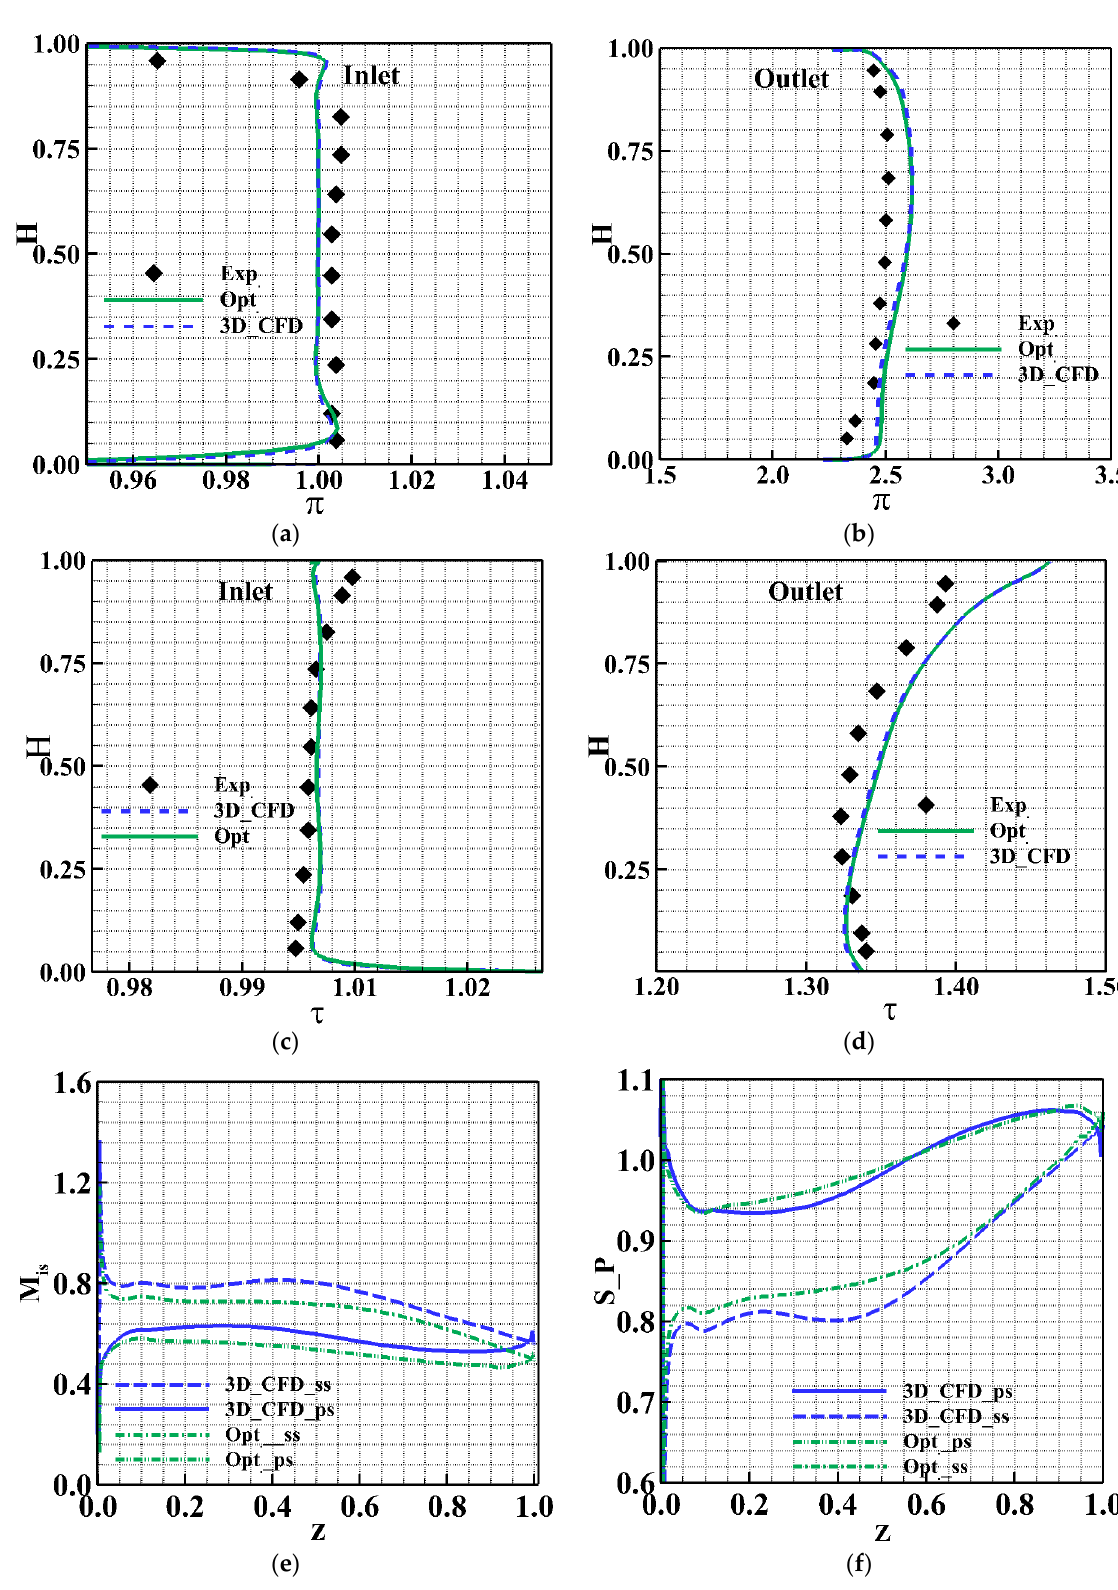
Figure 14. The spanwise distribution of aerodynamic parameters. ( a )The total pressure ratio at the inlet; ( b ) The total pressure ratio at the outlet; ( c ) The total temperature ratio at the inlet; ( d ) The total temperature ratio at the outlet; ( e ) The isentropic Mach number at the 0.5% span section of rotor1; ( f ) The static pressure at the 0.5% span section of rotor1.